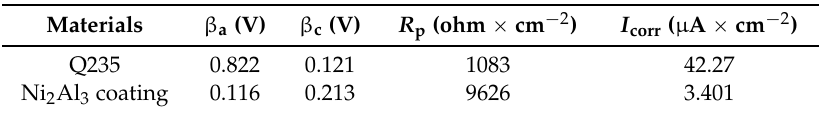
Figure 4. The polarization curves of the Ni 2 Al 3 coating and Q235 steel in the 3.5 wt. % NaCl solution. Table 1. Electrochemical corrosion parameter values for the Ni 2 Al 3 coating and Q235 steel in the 3.5 wt. % NaCl solution by polarization curve.